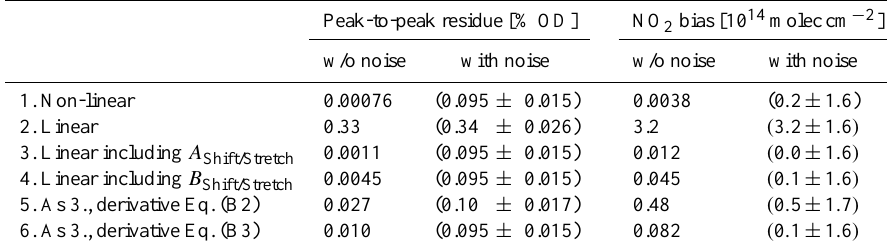
Table 2. Fit residues and NO 2 bias for a shift of 0.002nm. For the spectra affected to noise, the mean and standard deviation of 300 random spectra is given. All numbers are given with 2 digits, but in fixpoint notation so that the different orders of magnitude are directly visible. The last two fits (5. and 6.) refer to different methods for the calculation of the discrete derivative (see Appendix B) .